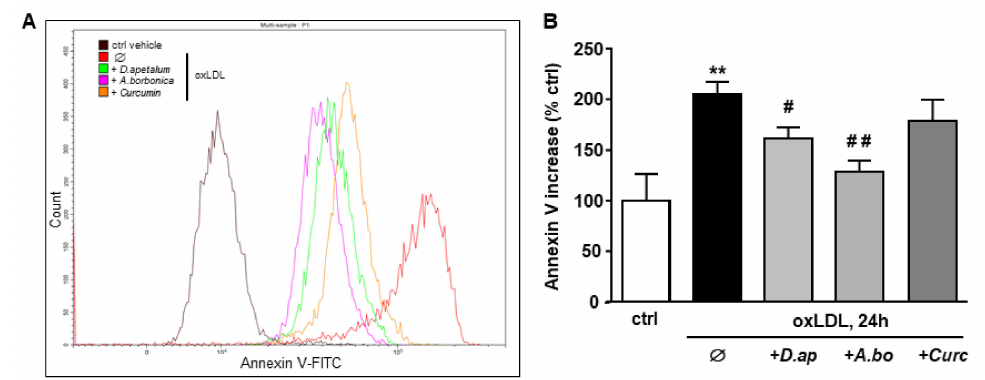
Figure 4. D. apetalum and A. borbonica extracts prevent oxLDL-induced phosphatidylserine ex- posure. Subconfluent serum-starved HMEC-1 cells were preincubated for 2 h with D. apetalum (25 µ M), A. borbonica (25 µ M) polyphenol-rich extracts or curcumin (10 µ M) before addition of oxLDLs (200 µ g apoB/mL) for an additional 24 h. ( A ) Illustration of detection of Annexin V binding in HMEC- 1 cells quantified by flow cytometry using Annexin V-FITC probe. ( B ) Graph represents percentage of Annexin V fluorescence relative to untreated control HMEC-1 cells (vehicle PBS) in each condition. Results are expressed as means ± SEM of 3 independent experiments. ** p < 0.01 vs. control (ctrl); # p < 0.05; ## p < 0.01 vs. oxLDL using one-way ANOVA with Tukey’s posthoc